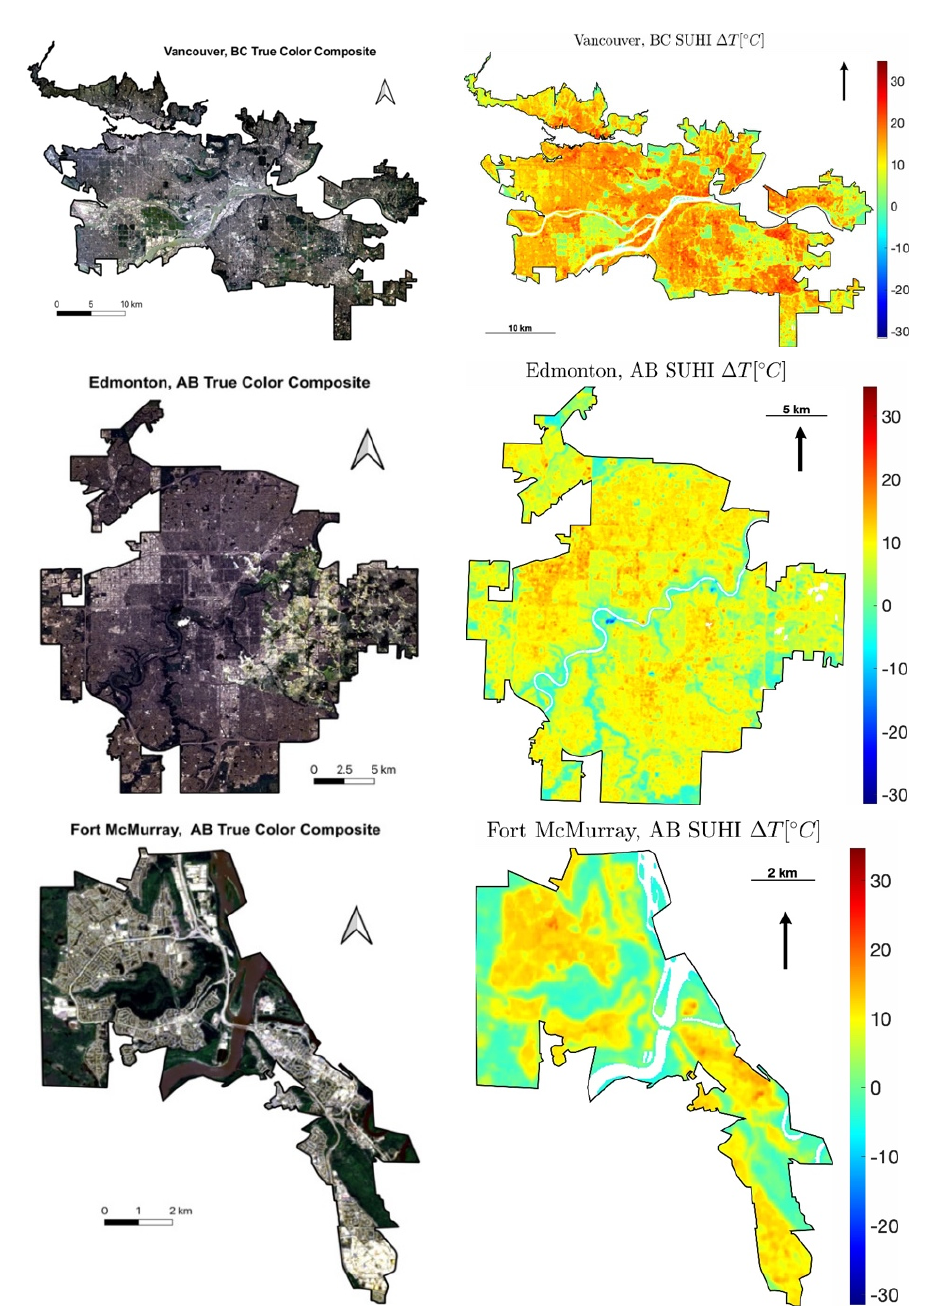
Figure 5. True color RGB composition maps and daytime SUHI intensity ( ∆ T) for four sample cities: Lewiston, Vancouver, Edmonton, and Fort McMurray.